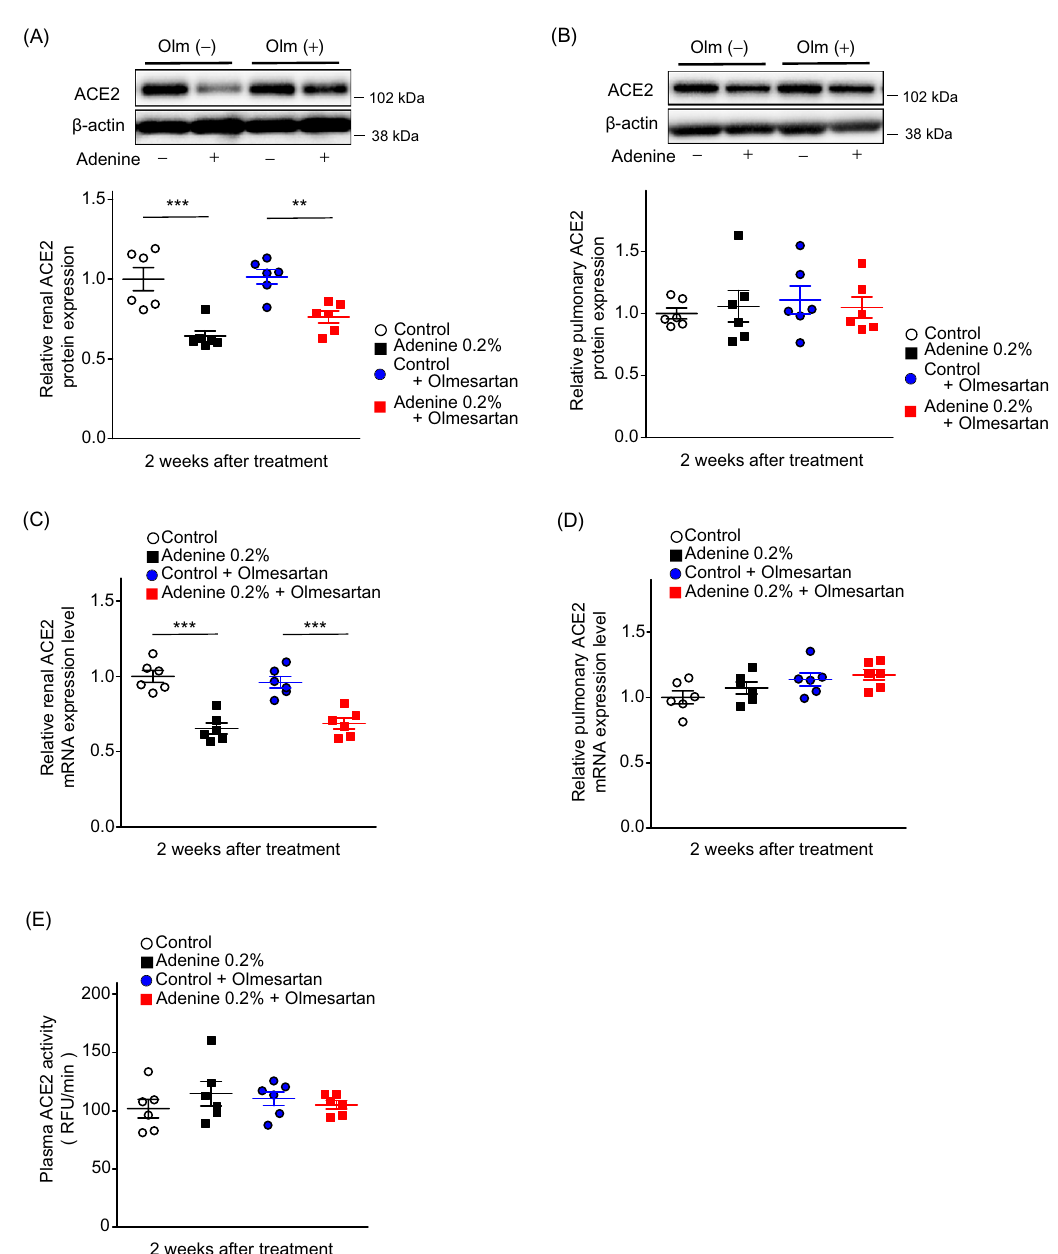
Figure 6. Effects of olmesartan administration on renal and lung ACE2 expression levels and plasma ACE2 activity. ( A ) Renal ACE2 protein expression levels and ( C ) mRNA expression levels in control, adenine, control-olmesartan, and adenine-olmesartan groups. ( B ) Pulmonary ACE2 protein expression levels and ( D ) mRNA expression levels in control, adenine, control-olmesartan, and adenine-olmesartan groups. ( E )